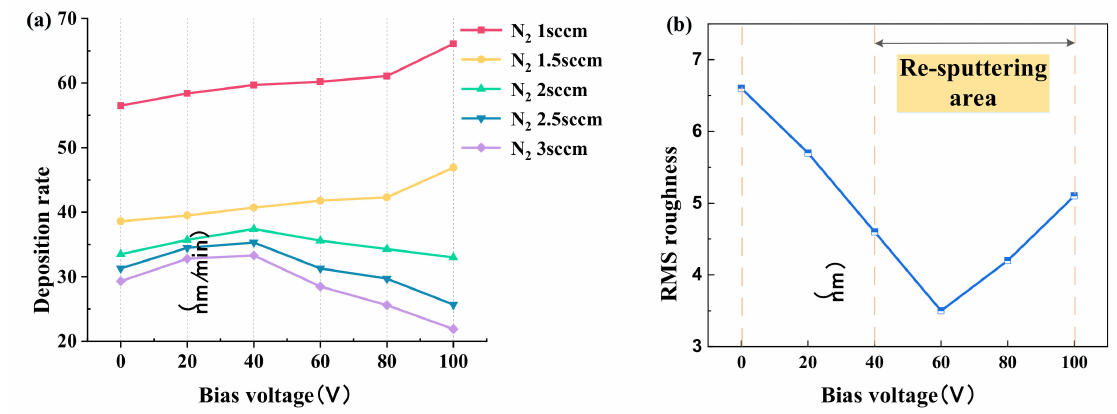
Figure 5. ( a ) Effect of different process parameters on the deposition rate of TiN film ( b ) Variation of RMS roughness of TiN film with negative bias voltage at a nitrogen flow rate of 3